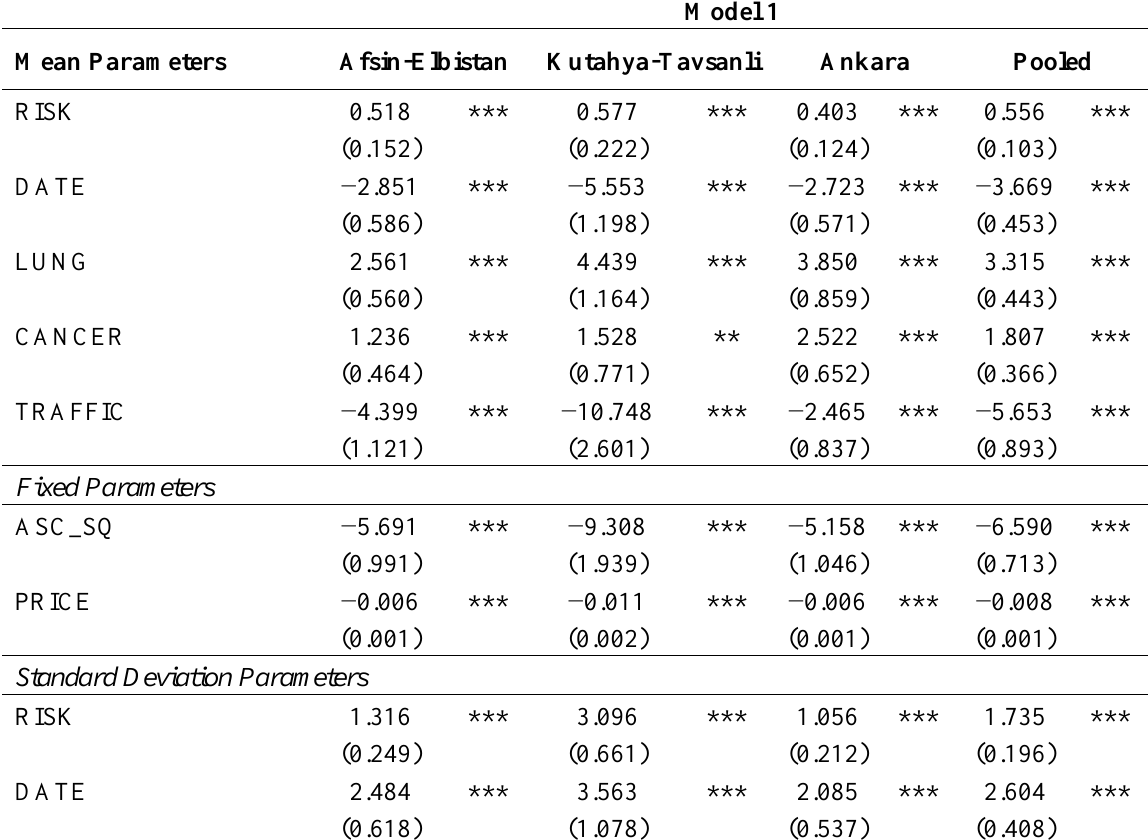
Table 5. Estimated Results for Model